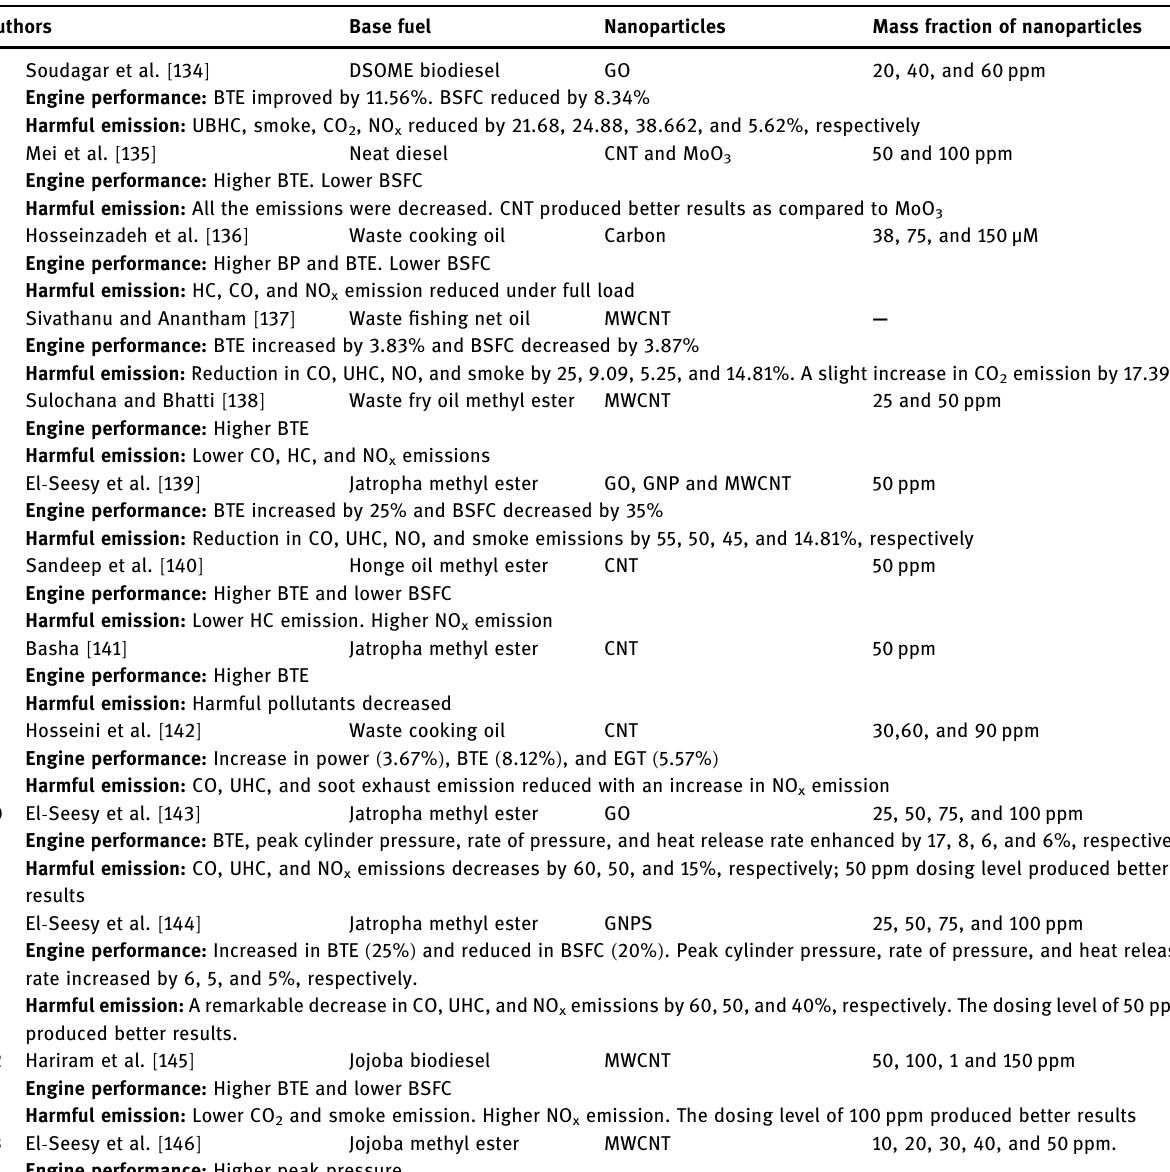
Table 6: Summary of non - metal oxides nanoparticles as an additive in diesel/biodiesel fuel Authors Base fuel Nanoparticles Mass fraction of